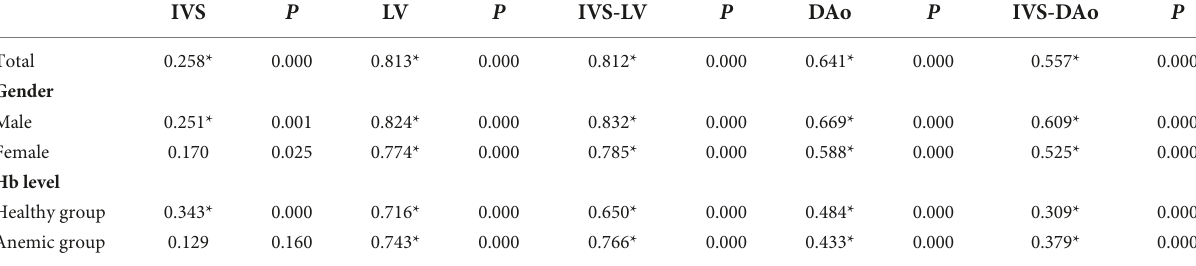
TABLE 5 Correlation coefficients of indicators with Hb level in CDCT